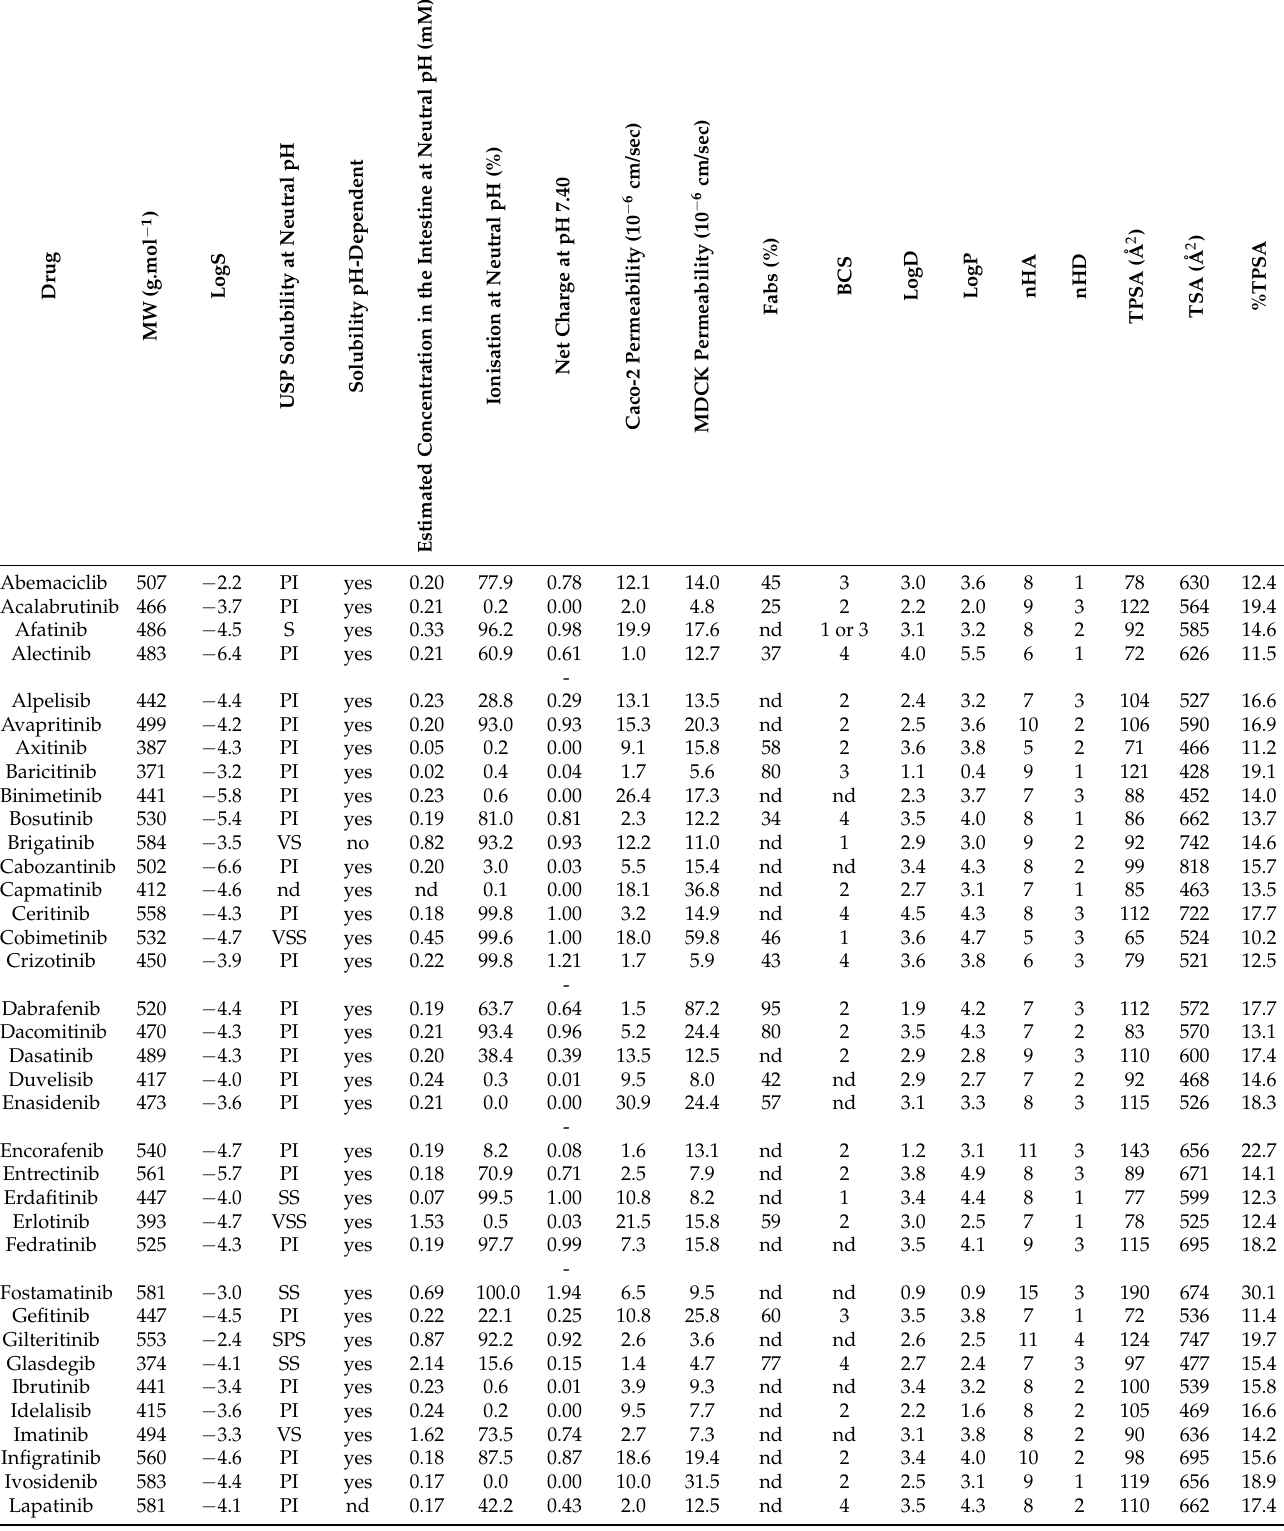
Table 1. Physicochemical and biopharmaceutic properties of 74 oral anticancer drugs. BCS